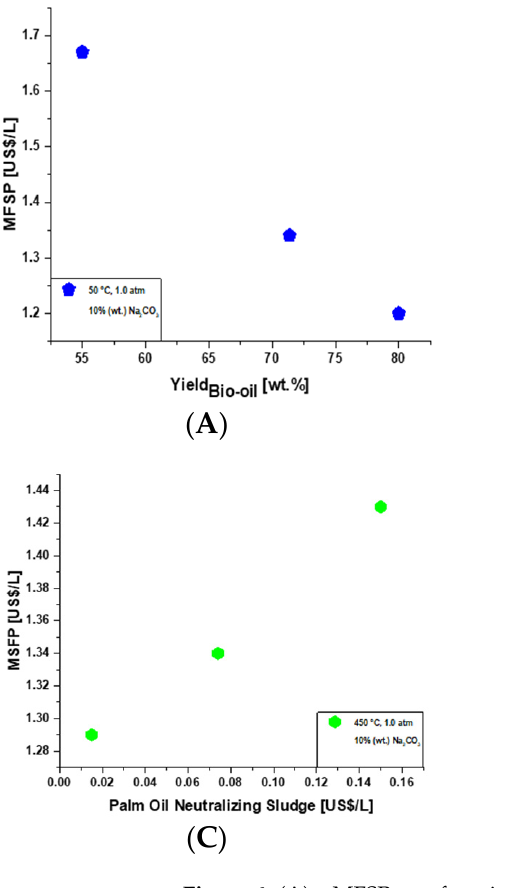
Figure 6. ( A )—MFSP as a function of bio-oil yield by sensitivity analysis for a 450 L/day production. ( B )—MFSP as a function of distillation yield by sensitivity analysis for a 450 L/day production. ( C )— MFSP as a function of cost of crude palm oil by sensitivity analysis for a 450 L/day production. ( D